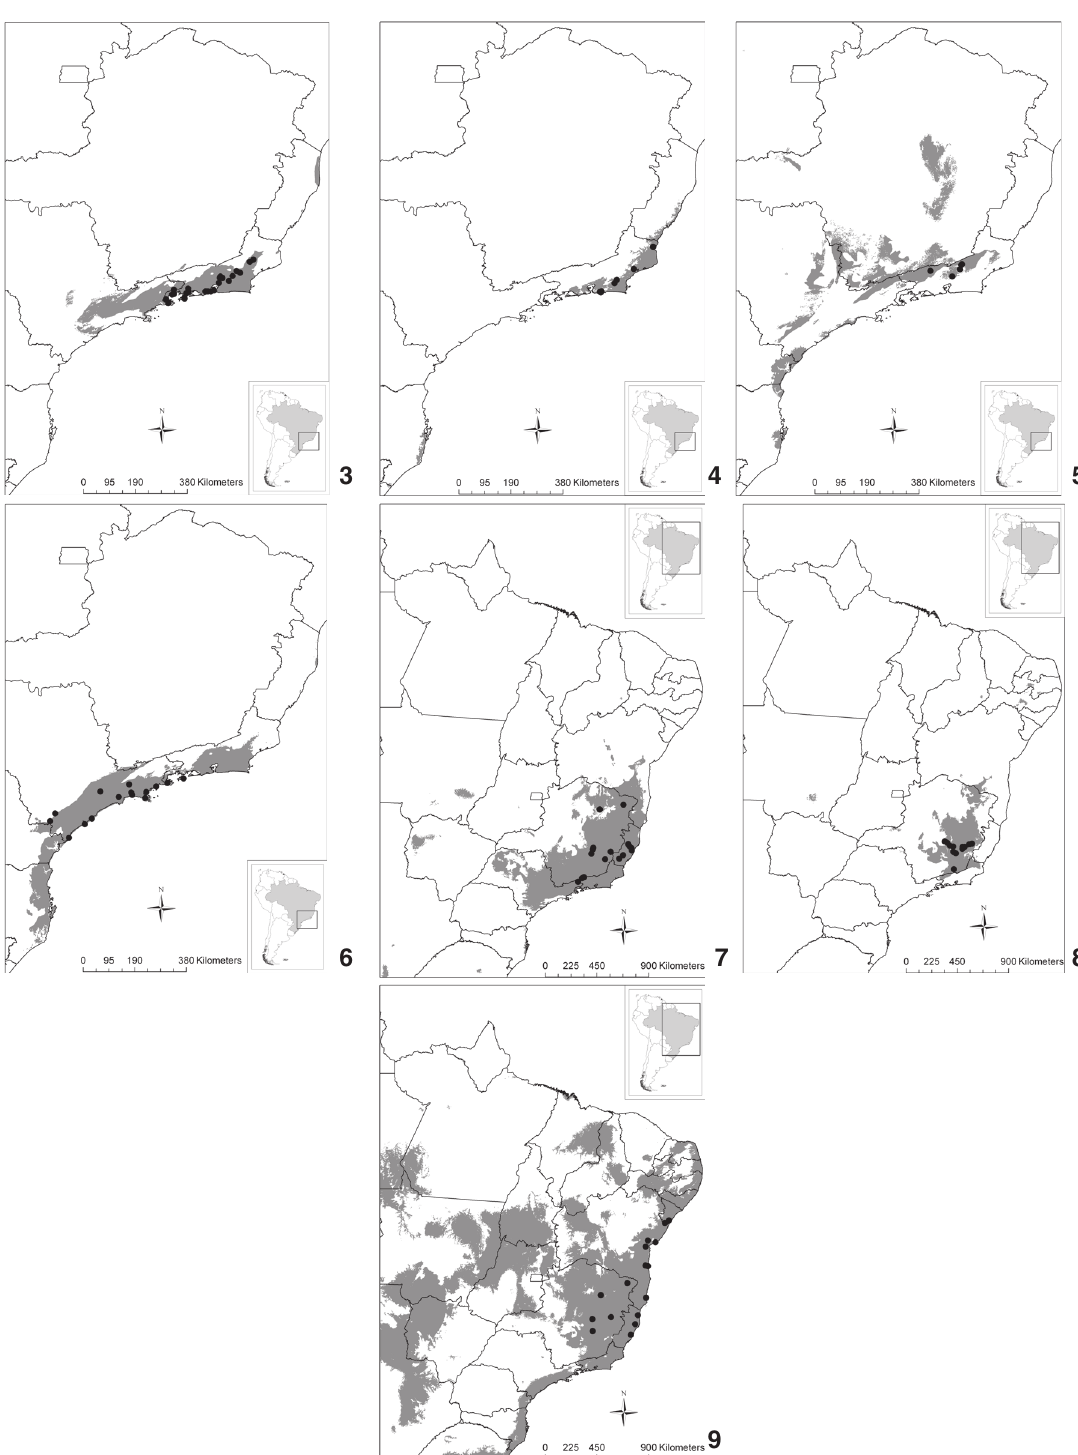
Figures 2-9. Potential distribution of Trinomys species in the Brazilian territory: (3) T. dimidiatus ; (4) T. eliasi ; (5) T. gratiosus bonafidei ; (6) T. iheringi ; (7) T. panema ; (8) T. setosus elegans ; (9) T. setosus setosus ZOOLOGIA 26 (2): 305–315, June, 2009